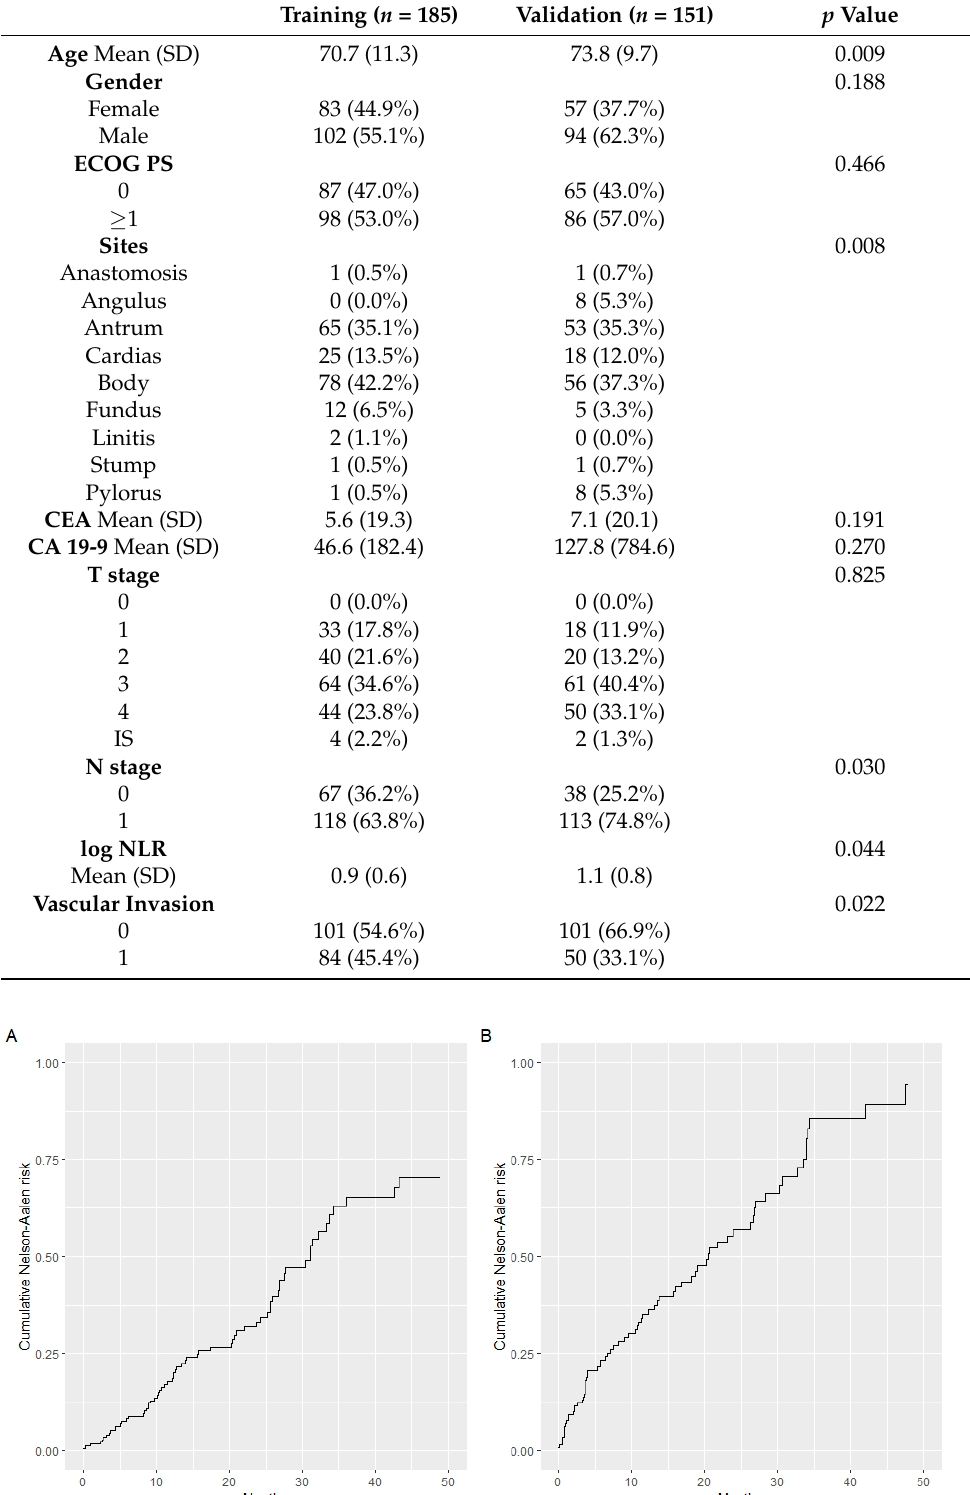
Table 1. Training and validation cohorts.